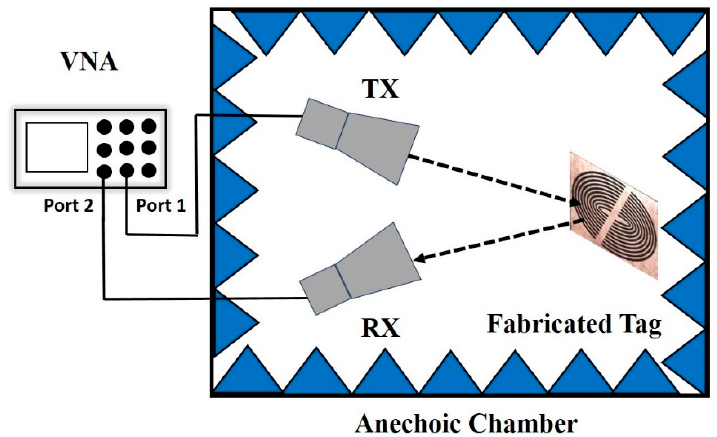
Figure 9. Block diagram of measurement system.